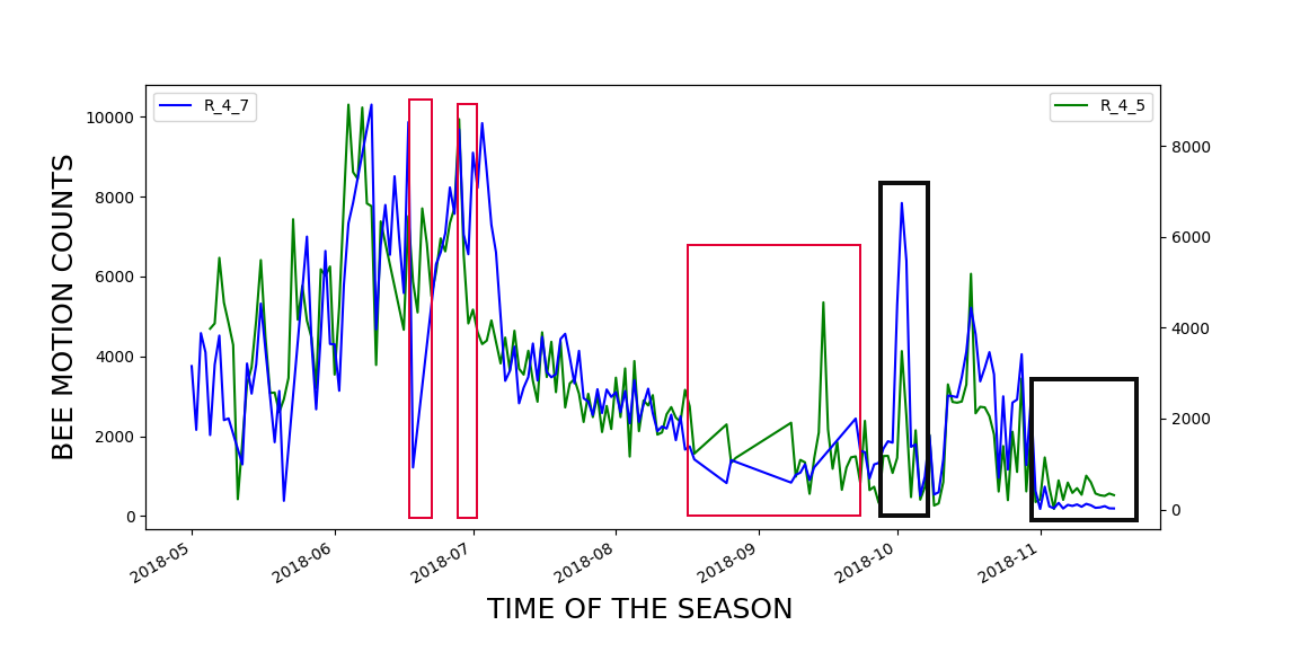
Figure 20. Bee motion counts for the entire season of 2018; red boxes signify time periods with lack of data due to hardware failures in either